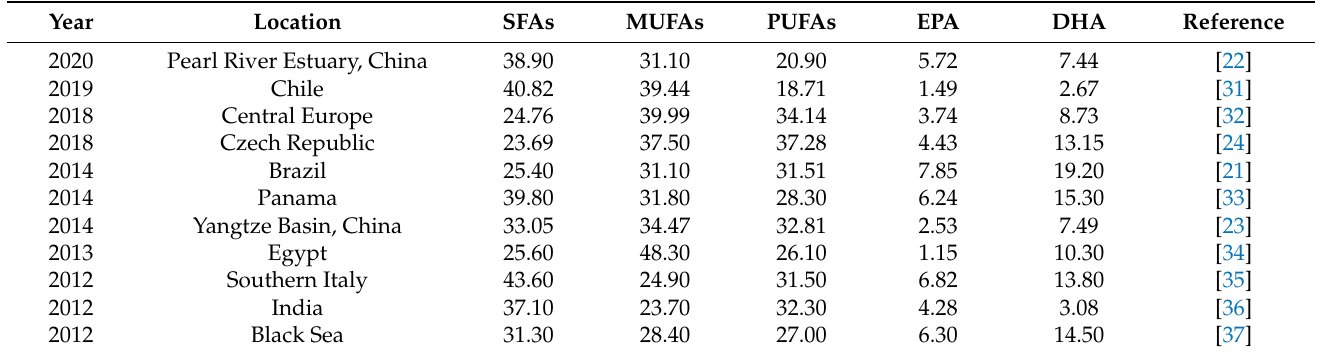
Table 2. Comparison of fatty acid profiles in fish species from different regions around the world over 10 years.